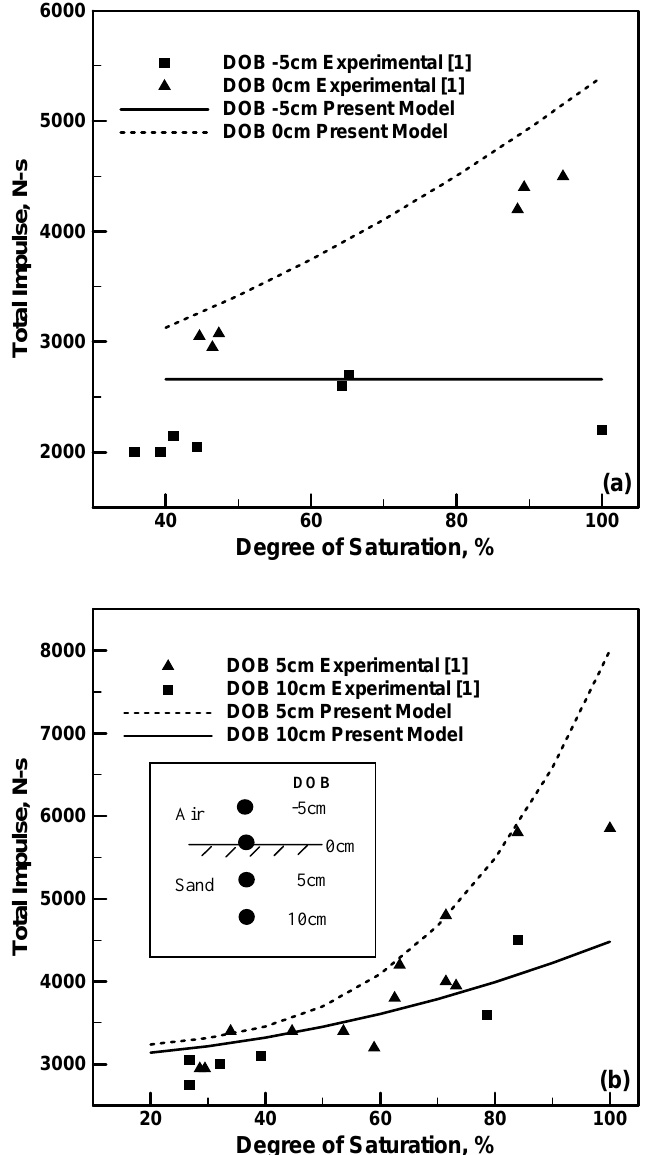
Fig. 6. The effect of degree of saturation and the depth of burial on the total impulse transferred to the instrumented horizontal mine-impulse pendulum. Explosive weight and type: 1.34 kg C4; Sand type: Prairie Sand. where the choice of the materials model for sand is essentially immaterial since only the gaseous detonation products interact with the pendulum. The observed discrepancy between the computed and the experimental results in the case of a − 5 cm DOB is a measure of the short comings of AUTODYN to accurately account for free-air blast